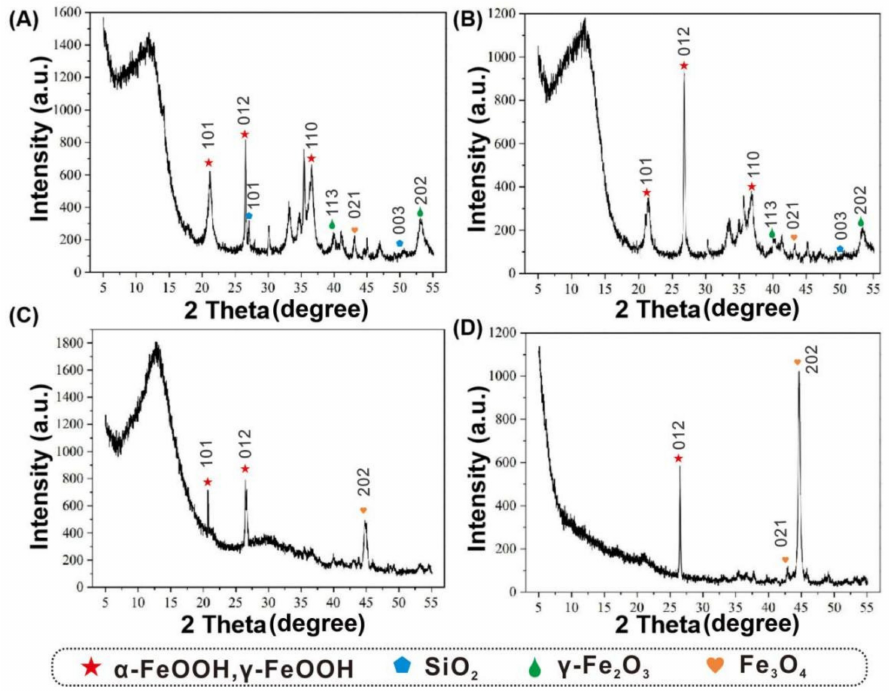
Figure 8. XRD spectrum. ( A – D ) XRD maps of four